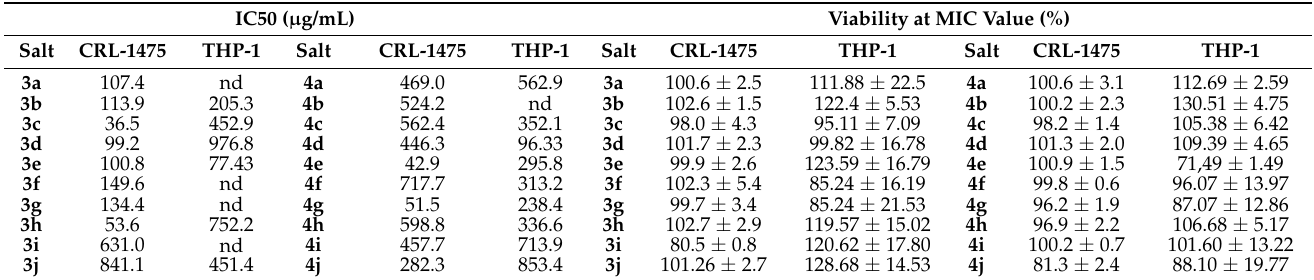
Table 6. IC50 values and viability at MIC values of imidazolium salts for CRL-1475 and THP-1 cells. IC50 ( µ